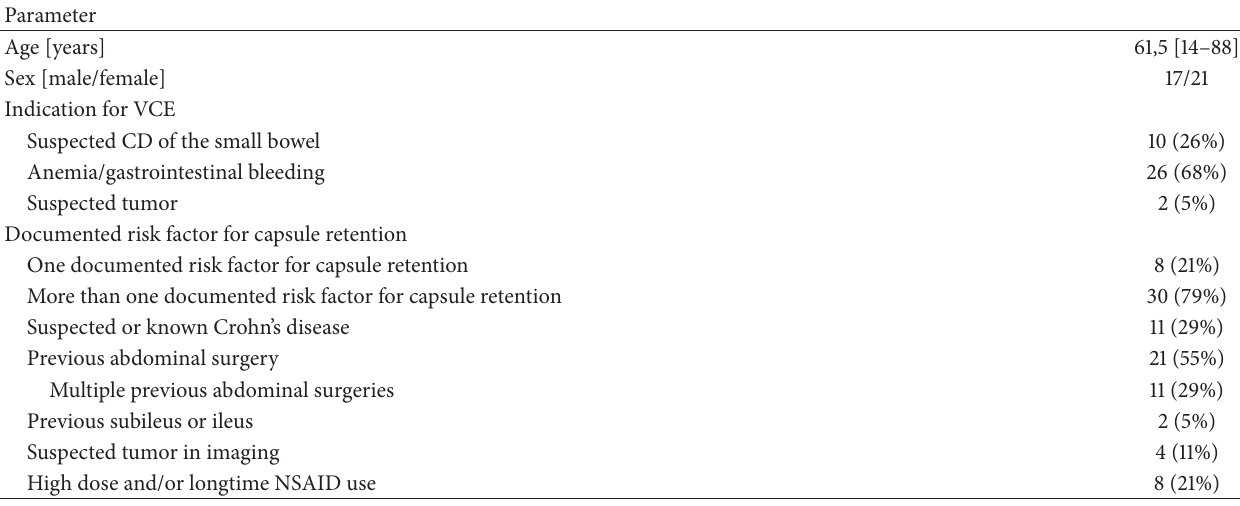
Table 1: Demographic and clinical characteristics of the study population: the main indications for the planned VCE were suspected Crohn’s disease of the small intestine or gastrointestinal bleeding. All 38 included patients had at least one risk factor for a capsule